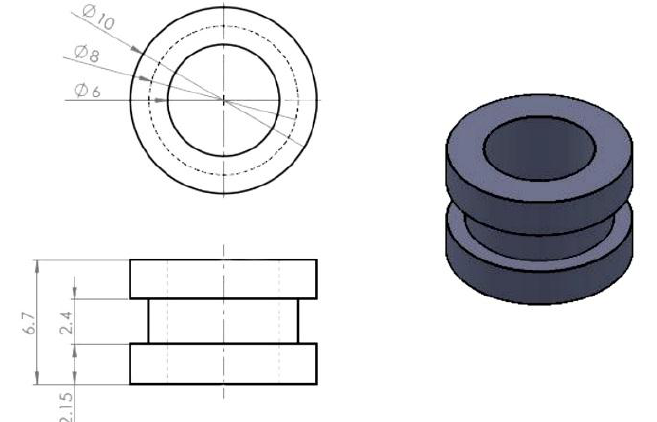
Figure 1. Dimensions of the AZ80 RCE with a U-shaped surface used in this